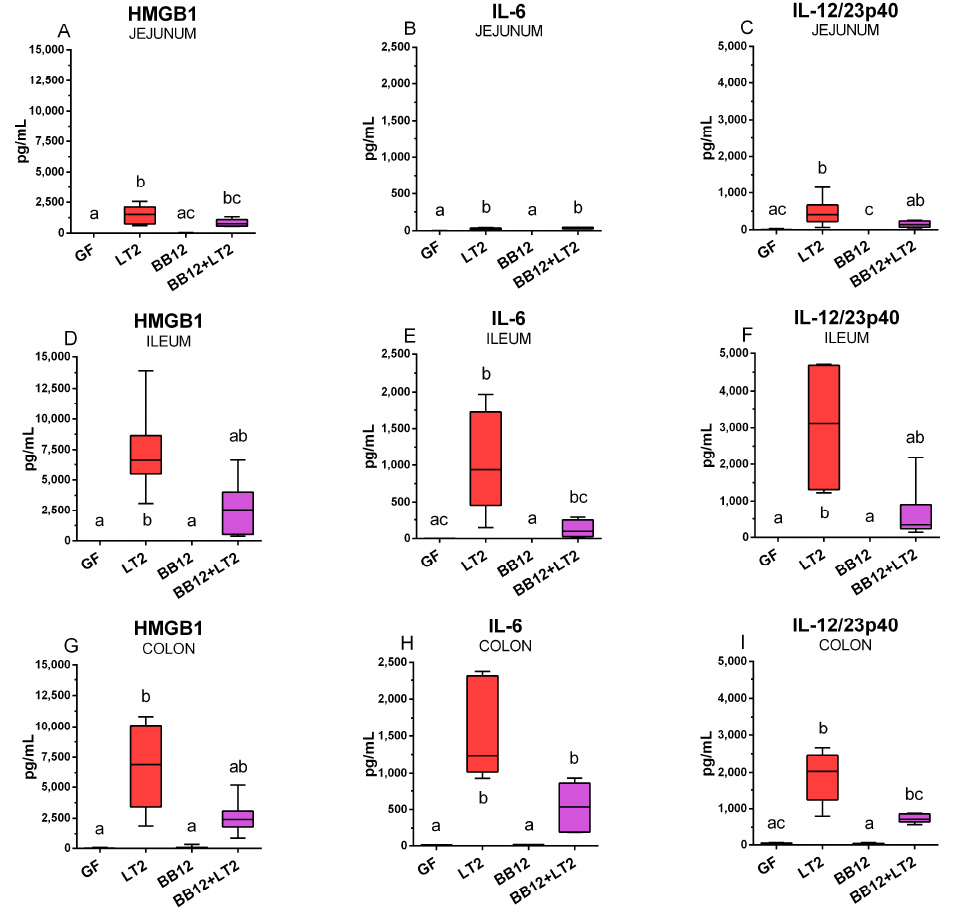
Figure 7. Abundance of HMGB1 ( A , D , G ), IL-6 ( B , E , H ), and IL-12/23p40 ( C , F , I ) proteins in the jejunum ( A – C ), ileum ( D – F ), and colon ( G – I ) of the one-week-old piglets: germ-free (GF), infected with S . Typhimurium LT2 for 24 h (LT2), associated with B. animalis subsp. lactis BB-12 (BB12), and associated with BB12 and infected with LT2 for 24 h (BB12 + LT2). Six samples from each group were analyzed, and statistical differences were calculated by the Kruskal–Wallis test with Dunn’s multiple comparison post hoc test. The values are presented as boxes and whiskers indicating the lower and upper quartiles, the central line is the median, and the ends of the whiskers depict the minimal and maximal values. A p < 0.05 among groups is denoted with different letters around the